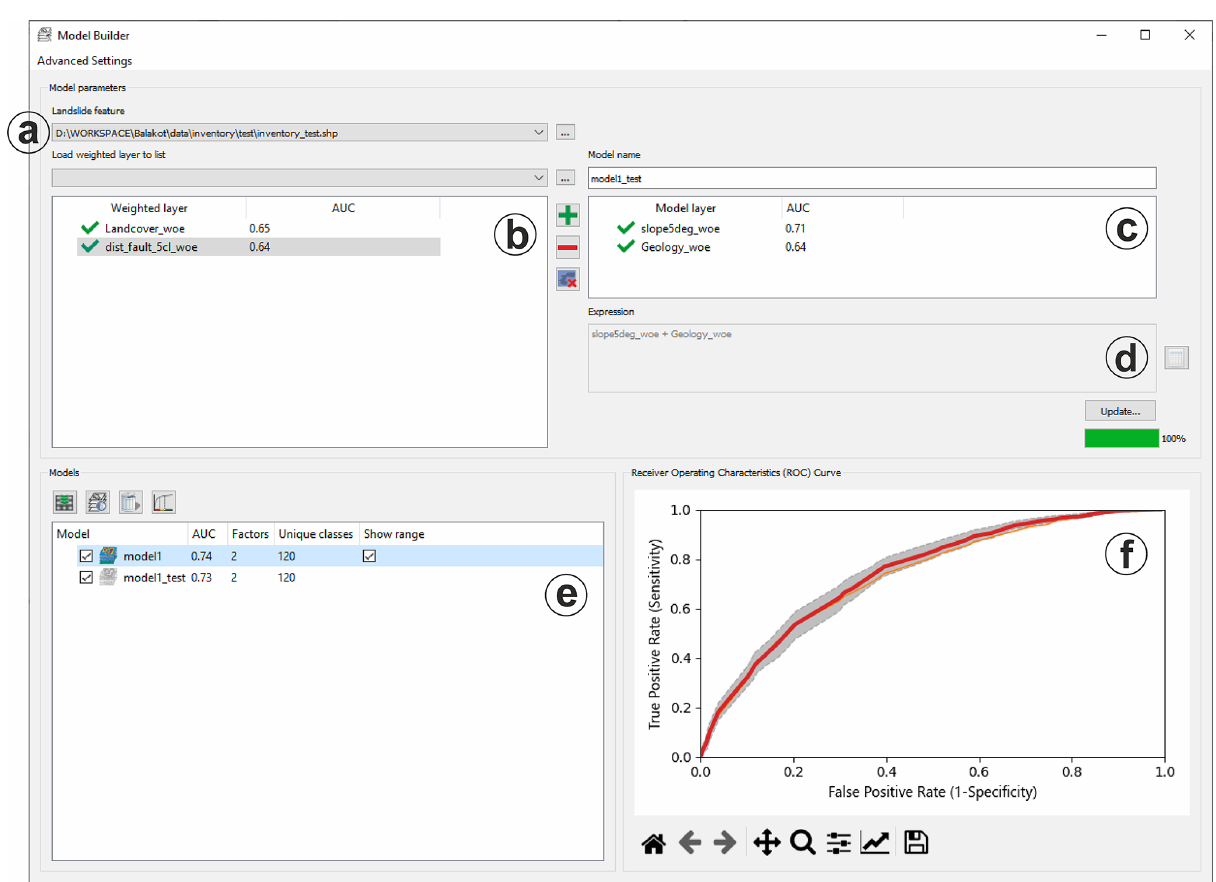
Figure 3. Model builder GUI with its integral parts: a – landslide inventory collection; b – weighted layer collection; c – model layer collection; d – model-generating expression; e – model collection; f – ROC